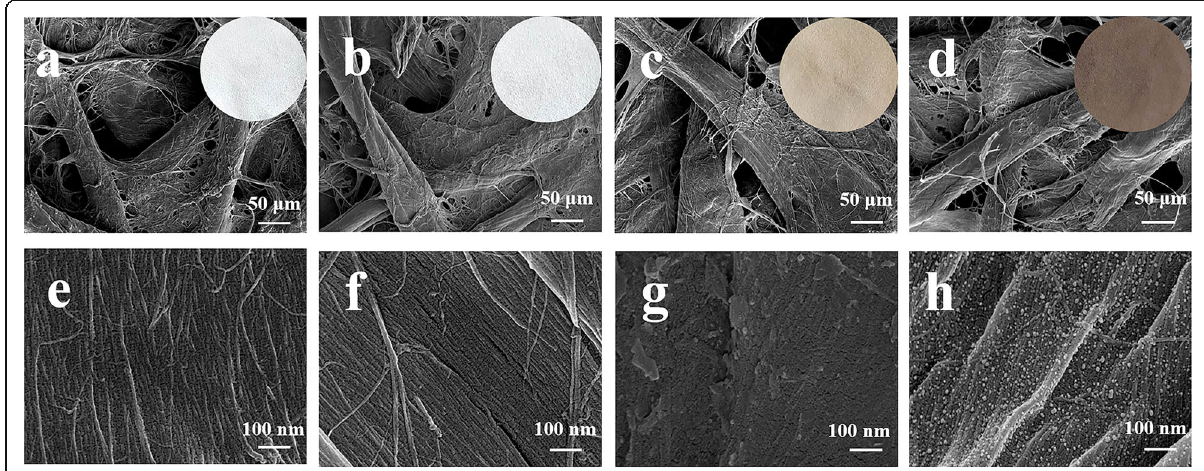
Fig. 2 SEM images of surface morphologies at different magnifications of a, e CP, b, f LA-CP, c, g GA@AgNPs-CP, d, h GA@AgNPs-LA-CP. The inset images in a, b, c, and d are photographs of corresponding cellulose paper samples